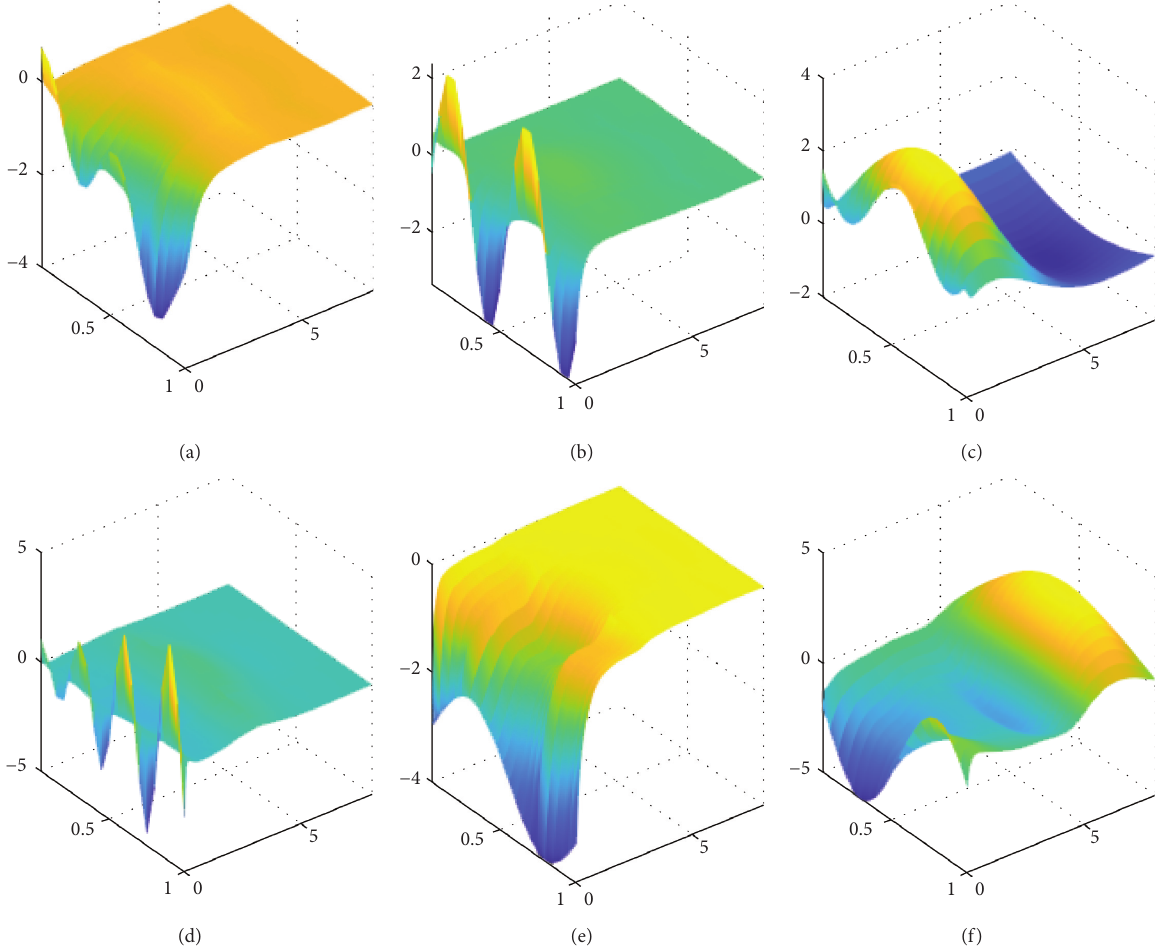
Figure 4: Imaginary part of state error evolution under the output static event-triggered control. net11, net12, and net13 represent 3- dimensional state evolution of the 1st error network. net21, net22, and net23 represent 3-dimensional state evolution of the 2nd error network. “im” denotes imaginary part. (a) net11-im. (b) net12-im. (c) net13-im. (d) net21-im. (e) net22-im. (f) net23-im.